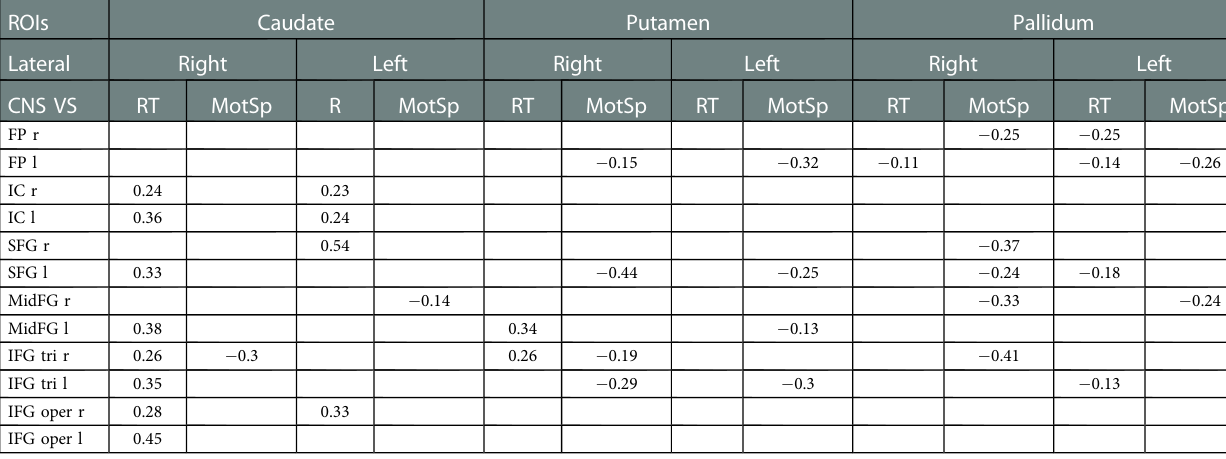
TABLE 3 Correlations of the functional connectivity z -transformed score of basal ganglia-frontal lobes and cognitive data. ROIs Caudate Putamen Pallidum Lateral Right Left Right Left Right Left CNS VS RT MotSp MotSp RT MotSp